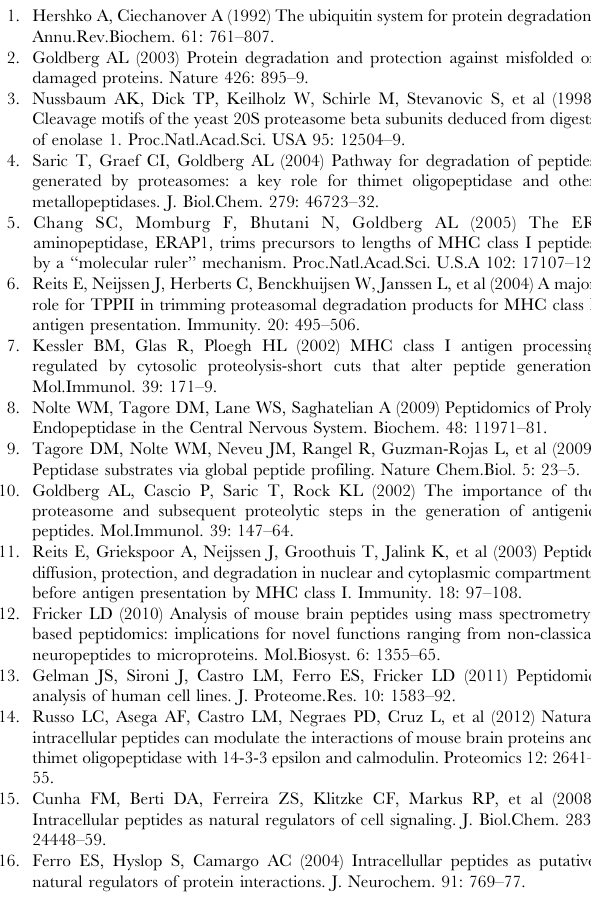
Table S1 Summary of peptidomic results from exper- iments involving proteasome inhibitors and other treatments of HEK293T and SH-SY5Y cells. This table lists each peptide observed in peptidomic studies, including both identified and unknown peptides. It contains . 6000 rows, with each row representing a peptide in a particular experimental run. Table S2 Data for heatmap figure. This table lists the peptides used for Figure 5, including peptide sequences, cleavage sites, and relative levels in treated versus control